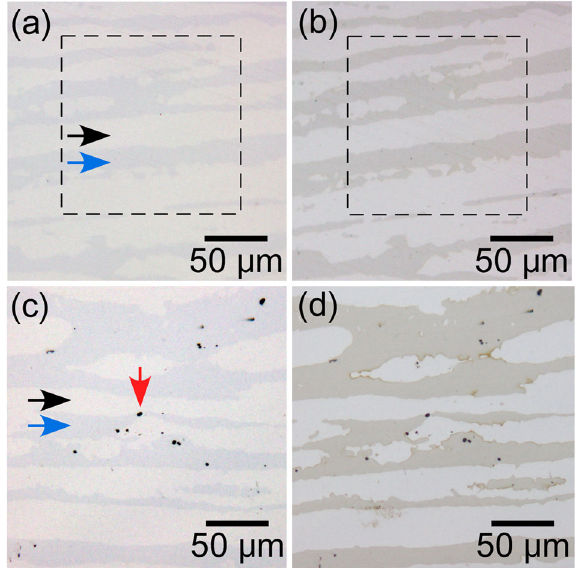
Fig. 1 Optical micrographs of the solution-treated specimen. a , b Area with few inclusions and c , d area with inclusions: a , c as- polished and b , d after etching.